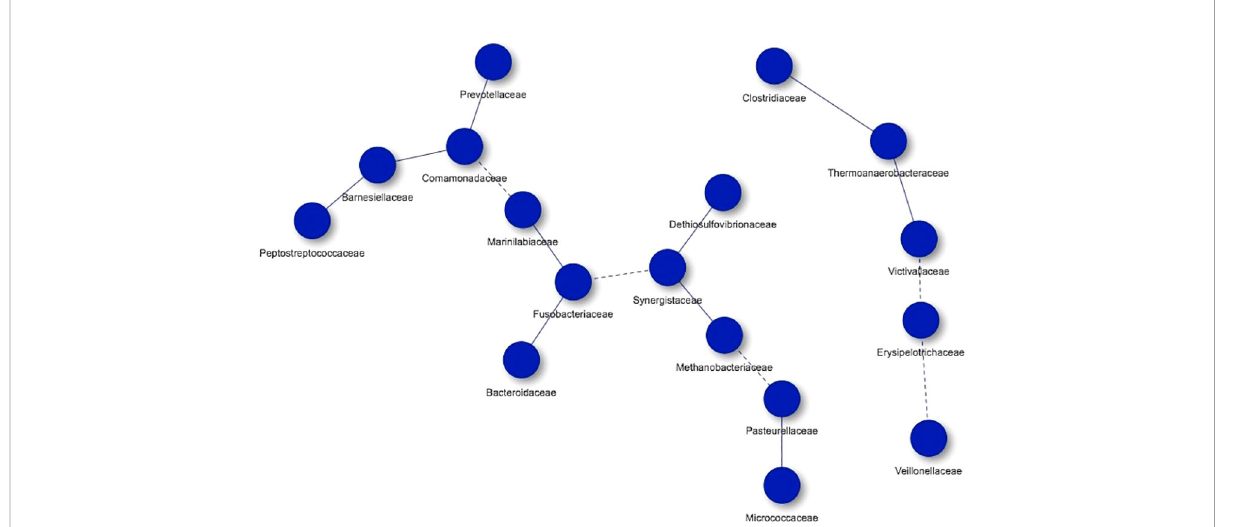
FIGURE 7 Co-occurrence networks of microorganisms present in controls. Continuous lines (edges) refer to co-occurrences that occur between microorganisms with a higher frequency than expected, while dashed lines correspond to interactions with less frequency than expected. P- value